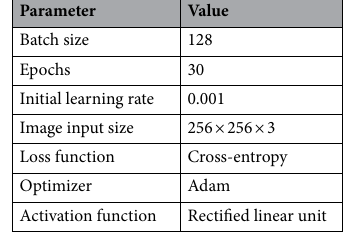
Table 2. The proposed network parameters.